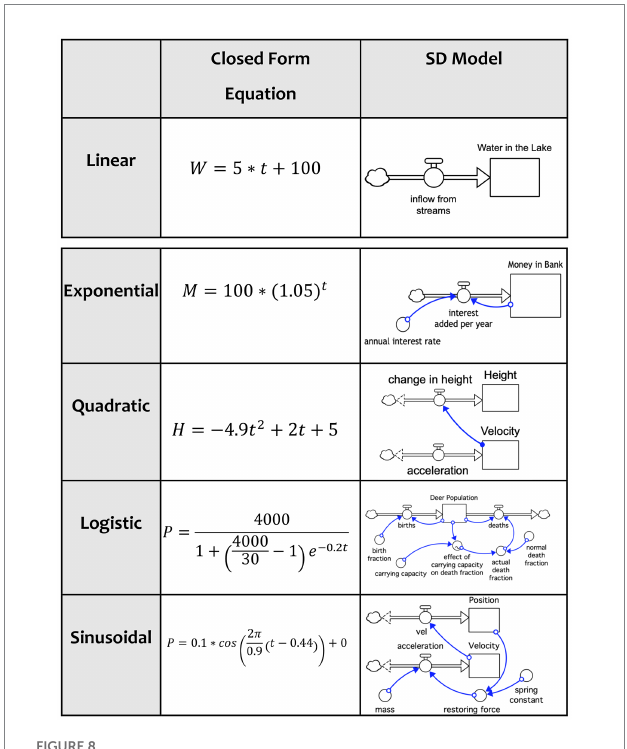
FIGURE 8 Equivalent closed-form mathematical function equations and stock- flow